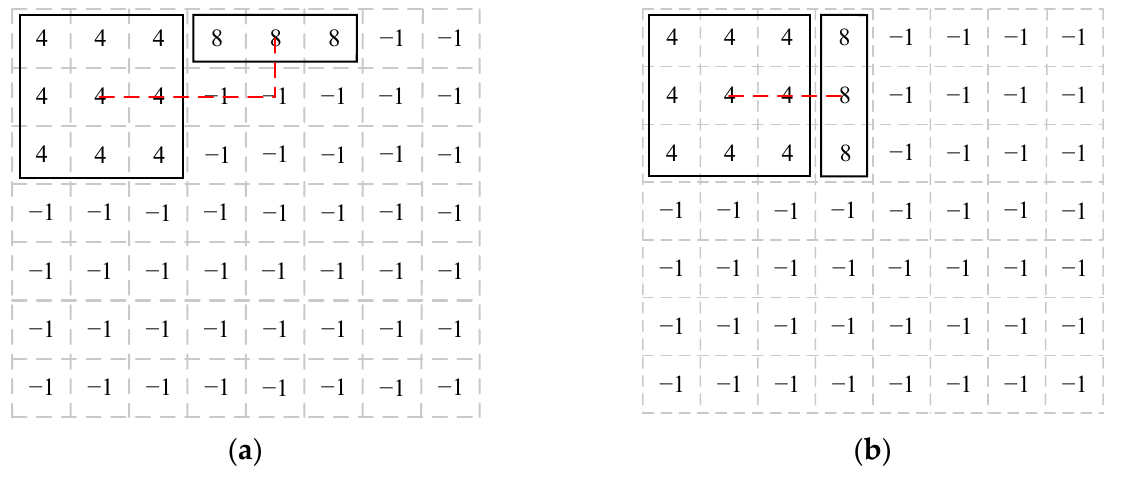
Figure 8. Di ff erent distance of ( a ) vertical and ( b ) horizontal placement. Figure 8. Different distance of ( a ) vertical and ( b ) horizontal